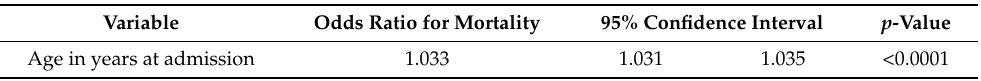
Table 4. Multivariate logistic regression analysis showing the adjusted odds ratios of age predicting the mortality for chronic obstructive pulmonary disease